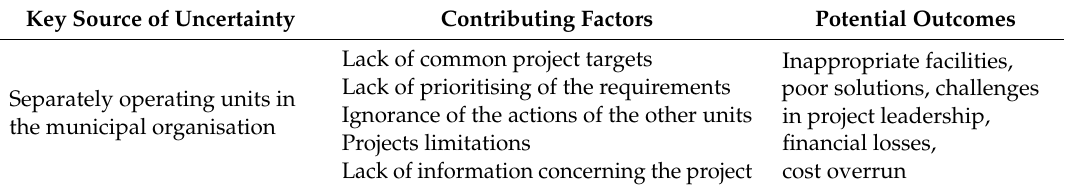
Table 4. The sources and the potential outcomes of the uncertainty concerning the organisation. Key Source of